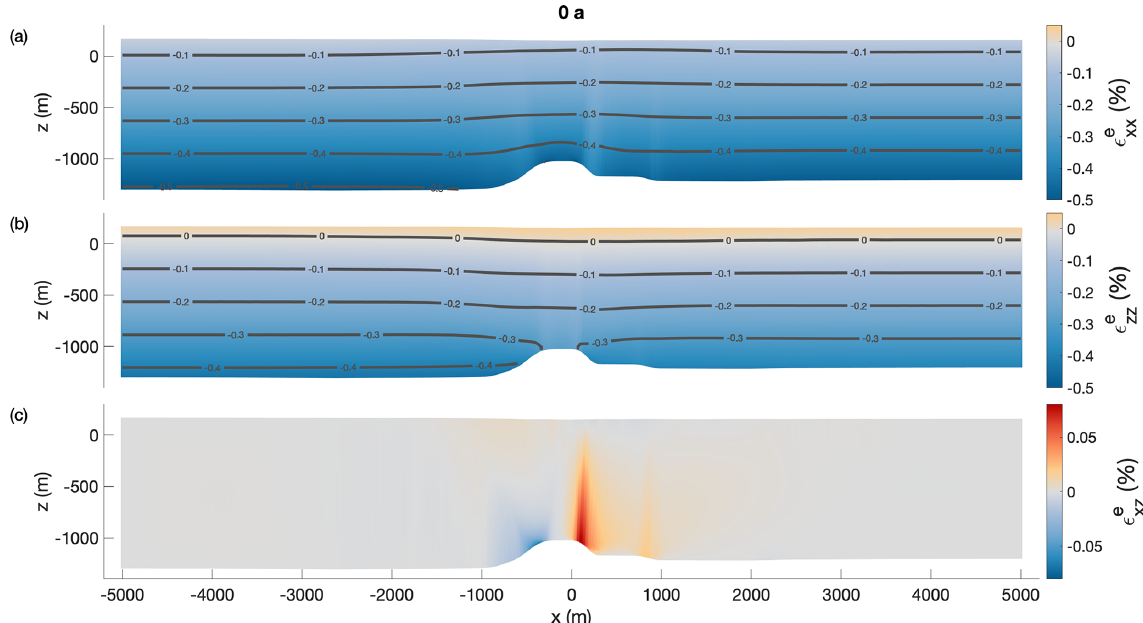
Figure B10. The simulated elastic part of Hencky strain (a) in the across-flow direction and (b) in the vertical direction, and (c) the shear component for the second experiment using synthetic melt rates at t = 0 year (after the spin-up, maximum lateral compression). The gray lines are contour lines of the elastic strain components. The normal components reach per mill values (the blueish colors denote compression), while the shear component is 1 order of magnitude smaller.